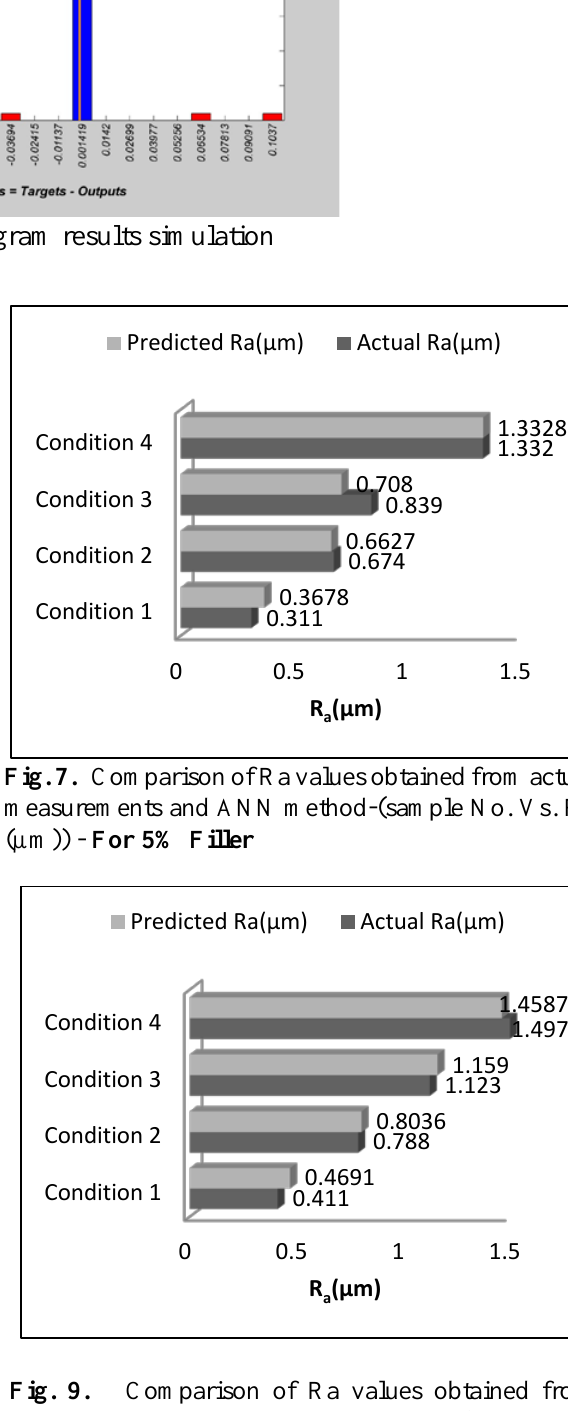
Fig. 8. Comparison of Ra values obtained from actual measurements and ANN method-(sample No. Vs. Ra (µm)) - For 10% Filler